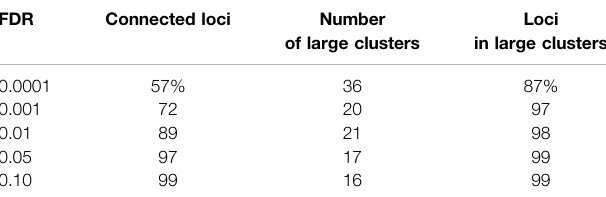
TABLE 1 | The effect of edge FDR on locus clustering. To apply the Louvain clustering algorithm, we constructed a graph in which loci were represented by nodes and edges between nodes represented loci with similar accessibility patterns. We placed edges between two nodes at different FDR. Shown are the percent of loci that were connected to another locus (connected loci), the number of clusters with more than 30 loci (number of large clusters), and the fraction of loci that fell within a large cluster (loci in large